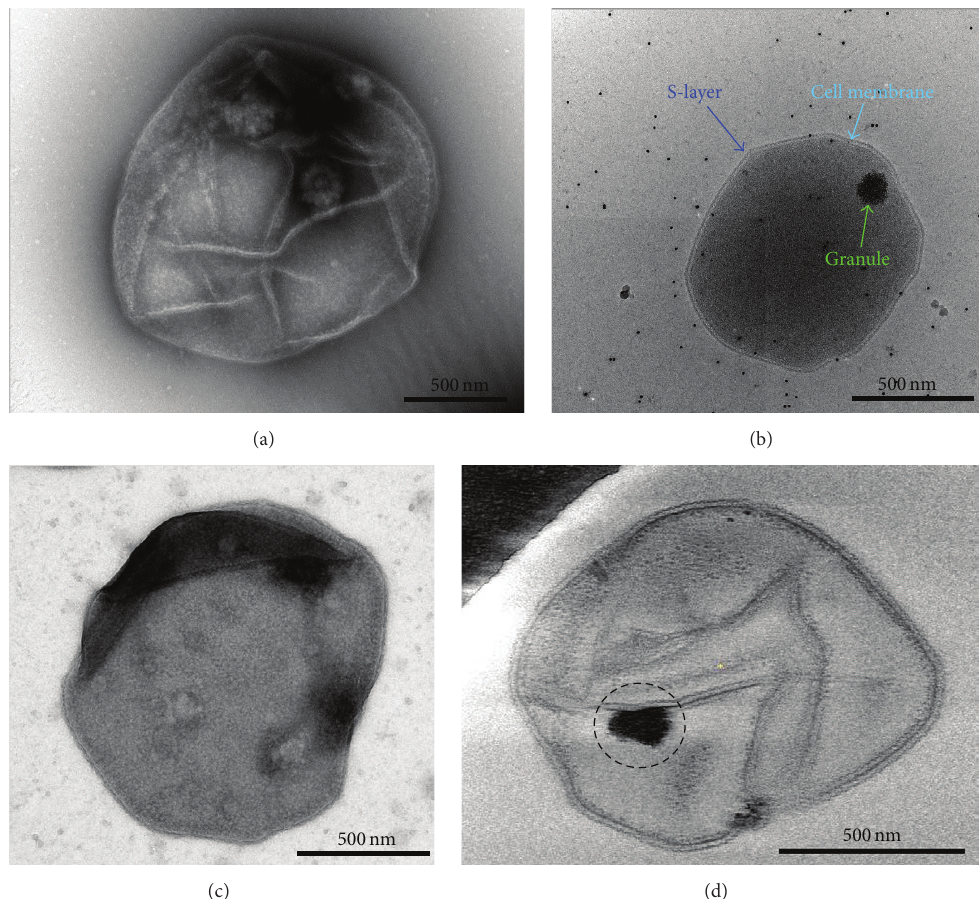
Figure 1: Electron microscopy of A. fulgidus cells and visualization of intracellular granules. (a, b) Transmission electron microscopy images of an A. fulgidus cell stained by 1% uranyl acetate (UA) (a) or embedded in vitreous ice (b). (c, d) Representative TEM images of cell ghosts of A. fulgidus stained with UA (c) or embedded in vitreous ice (d). The remains from a possible dense granule are circled